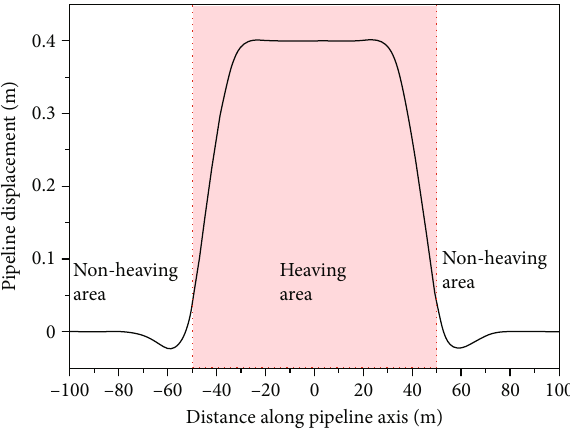
Figure 6: Pipe vertical displacements under frost heave displacement of 0.4m based on fi nite length frost heave